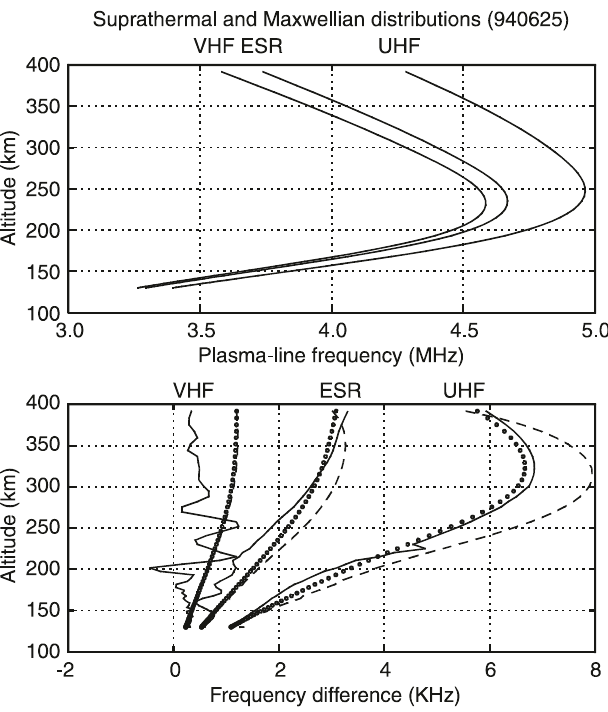
Fig. 13. Same plates as in Fig. 12. The compared distribution functions are a Maxwellian and a Maxwellian superposed with a suprathermal. The line codes are identical to the codes used in